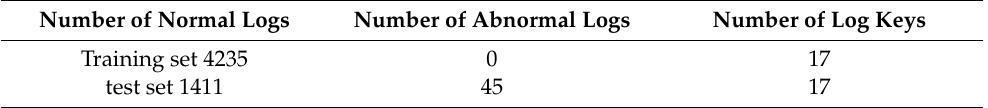
Table 2. Training set and test set data